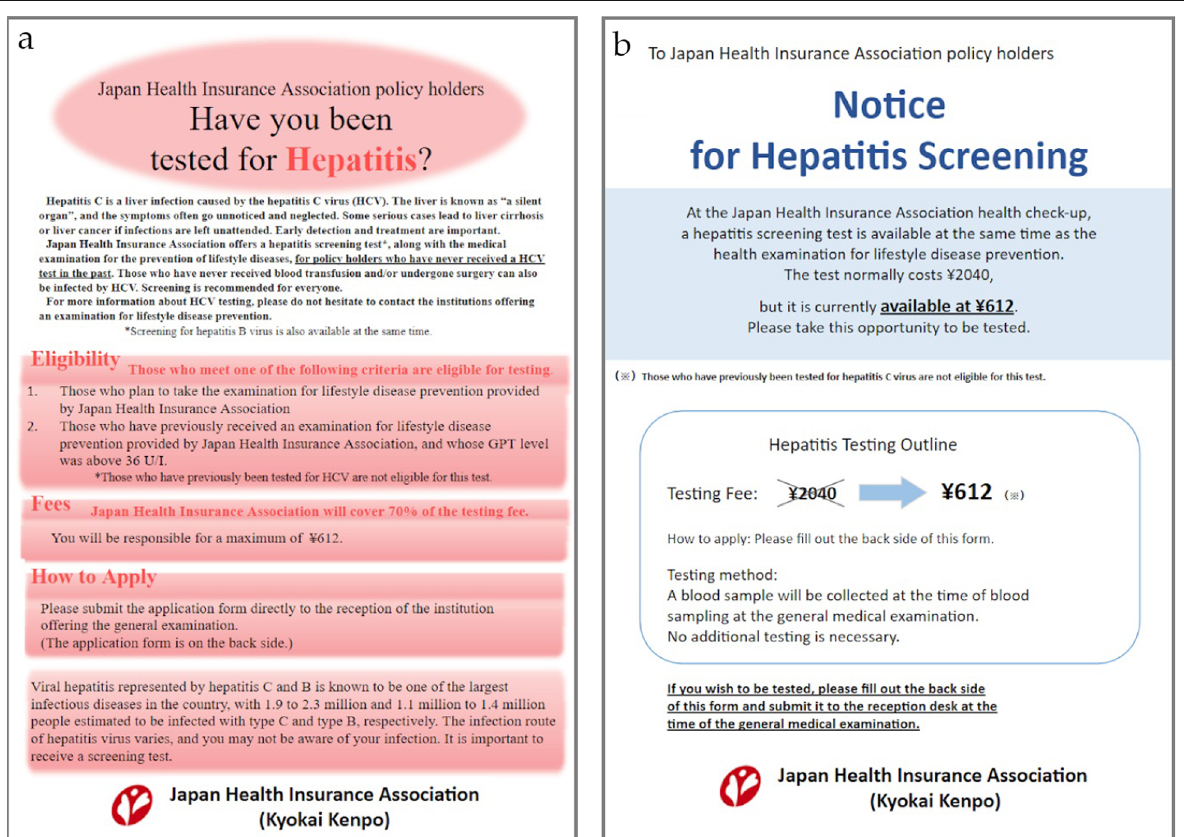
Fig. 2 Client reminders (translated). a Control group client reminder. b Group A client